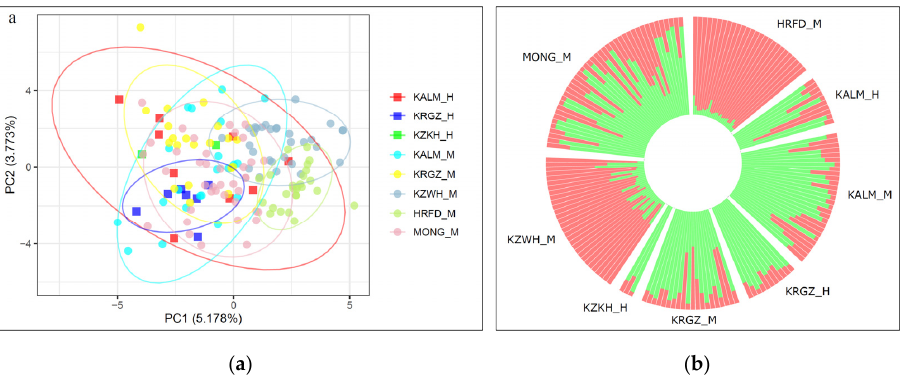
Figure 2. ( a ). Principal component analysis (PCA) of the museum and modern cattle populations. X-axis, principal component 1 (PC1); Y-axis, principal component 2 (PC2); ( b ). Genetic structure of museum and modern cattle populations revealed by STRUCTURE analysis for the number of clus- ters K = 2. Museum populations: KALM_H—Kalmyk, KRGZ_H—Kyrgyz, KZKH_H—Kazakh,